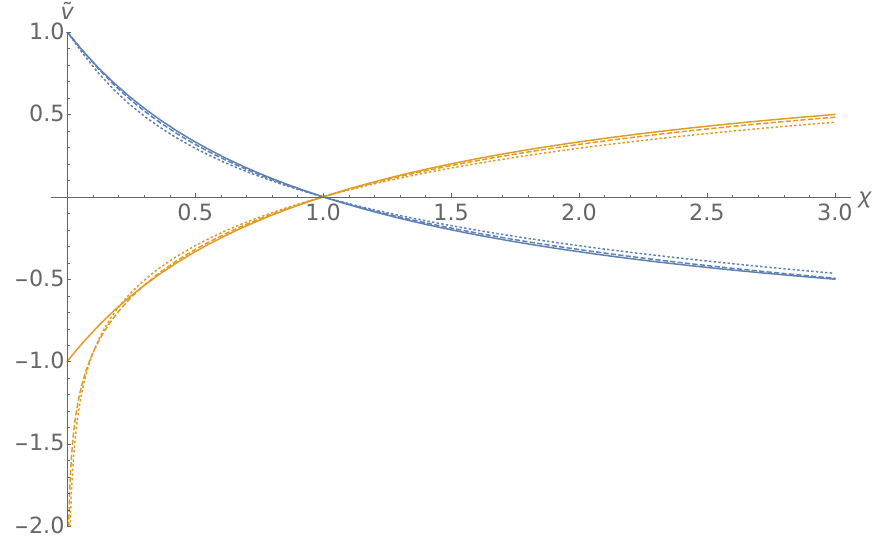
Figure 23 . Normalised entropy increase and decrease rates (7.11), (7.12) for d = 2 (solid), d = 3 (dashed) and d = 4 (dotted) as a function of (cid:31) . Note that in the formulas (7.11), (7.12), ~ v L > 0, ~ v R < 0 for (cid:31) > 1 and ~ v L < 0, ~ v R > 0 for (cid:31) < 1. While 1 (cid:21) ~ v L;R (cid:21) (cid:0) 1 for d = 2, we see that 1 (cid:21) ~ v L;R with no lower bound for d >